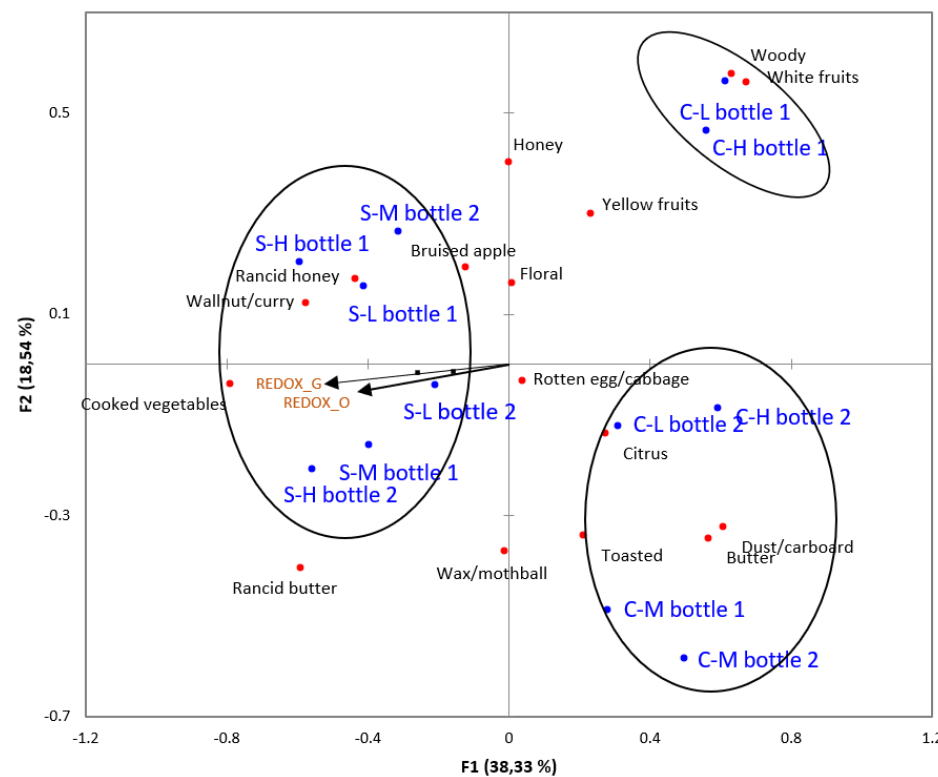
Figure 3. Correspondence Analysis of the general description of the two bottles of each 2010 sample. Ellipses indicate the clusters obtained by HCA using Ward’s criterion. O: orthonasal; G: global.